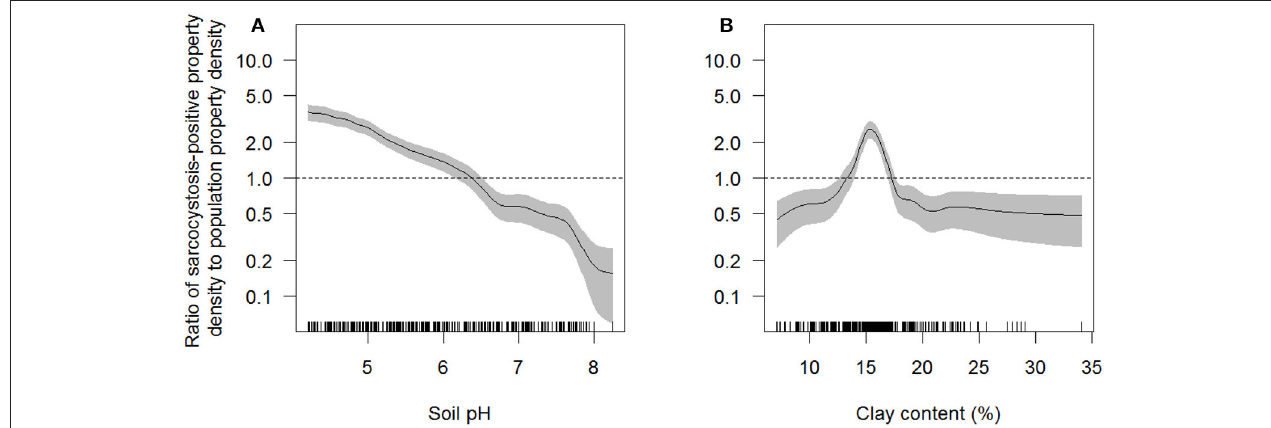
FIGURE 3 | Ratio of sarcocystosis-positive farm density to population farm density as a function of soil pH (A) and clay content (%) in the top 0–5cm of soil (B) estimated across South Australia using the rhohat procedure. The solid line shows function estimate; gray shading is pointwise 95% confidence band. The vertical dashes along the horizontal axis represent individual data points. The horizontal dashed line represents the null association (density of sarcocystosis-positive farms equals the density of all farms at risk). Interpretation: for those areas in the study area where soil pH was ∼ 5 the intensity of sarcocystosis-positive farms was ∼ 2 times that of all farms at risk. Data represent 4,204 sheep farms that submitted sheep for slaughter during the period 2007–2017.